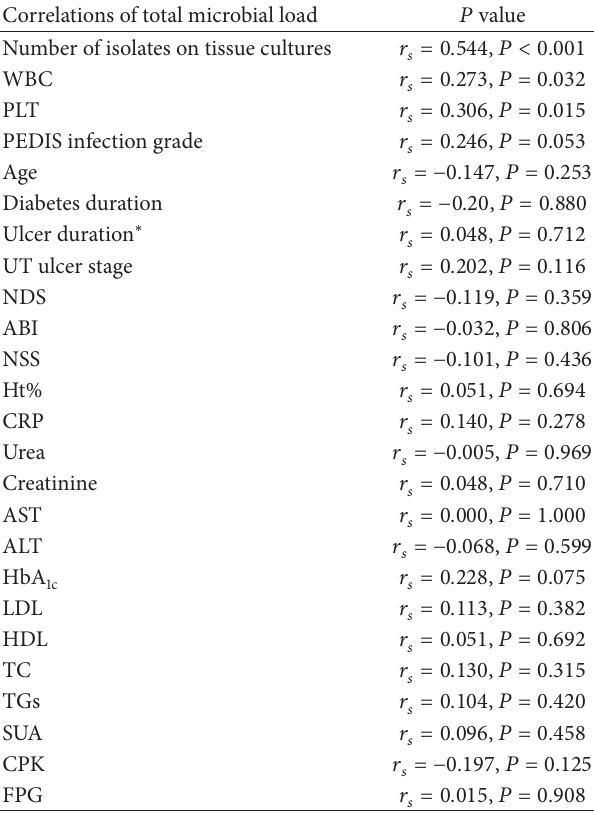
Table 2: Correlations of total microbial load. Correlations of total microbial